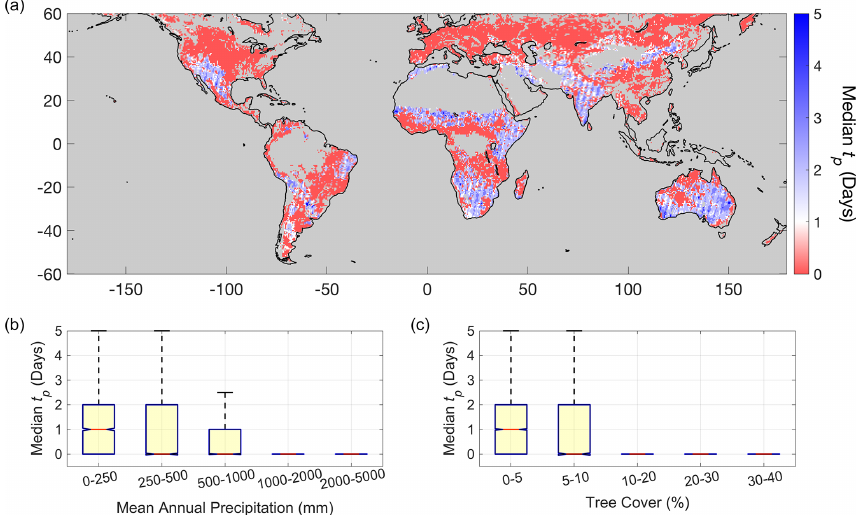
Figure 2. Median time to peak plant water content ( t p ) after soil moisture pulse. (a) Median t p global distribution. Median t p binned as a function of (b) mean annual precipitation and (c) tree cover. Mostly bare surfaces with low vegetation density are masked. Densely forested areas (tree cover > 40%) are masked due to limitations in VOD estimation for dense canopies.